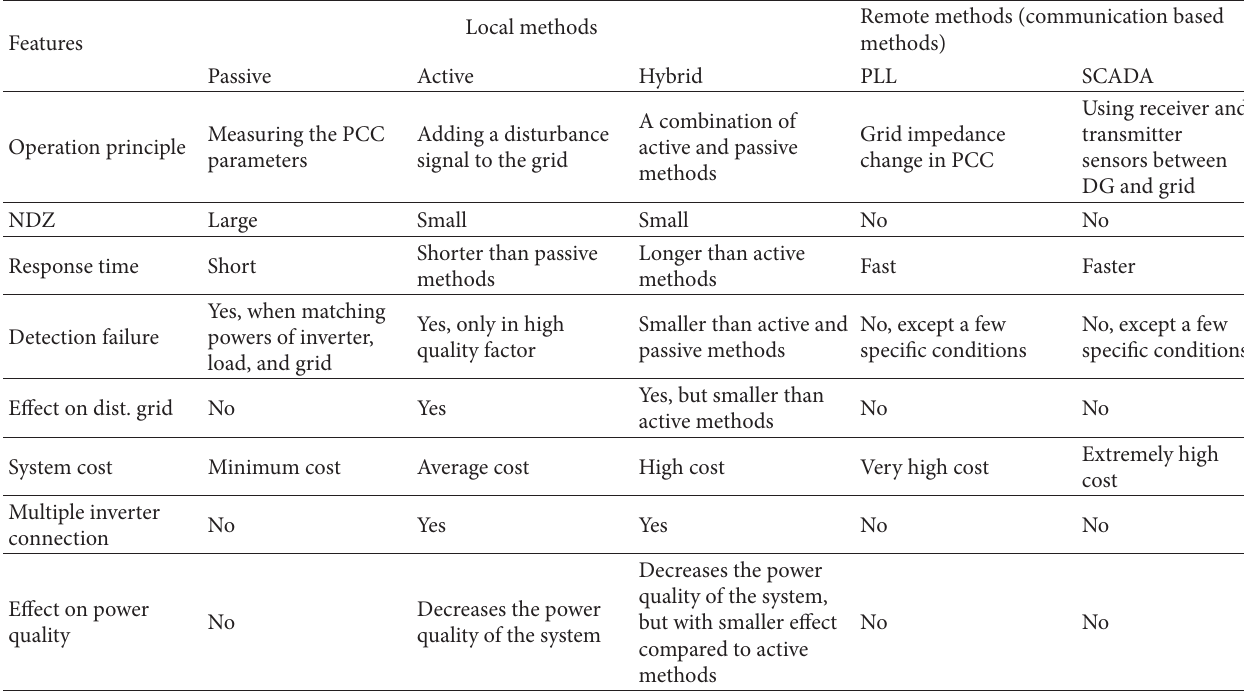
Table 2: A comparison of current islanding detection